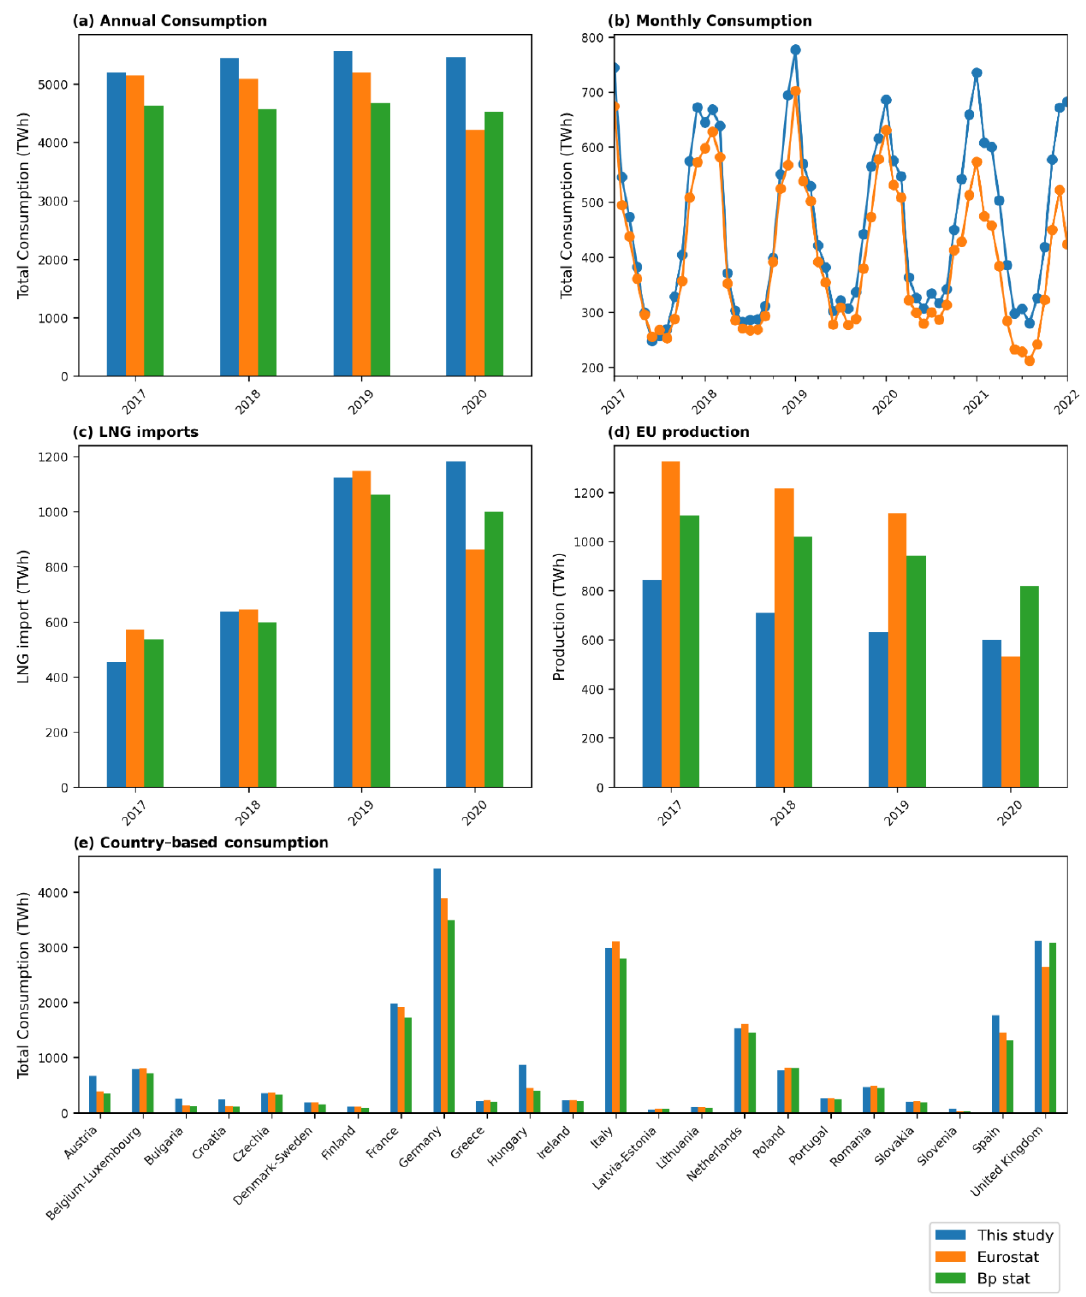
Figure 3. Data comparisons among the dataset in this study, Eurostat, and BP Statistical Review of World Energy. The figure panels show the comparisons for (a) total annual consumption, (b) total monthly consumption, (c) total annual LNG imports, (d) total annual EU gas production, and (e) total country-based consumption from 2017 to